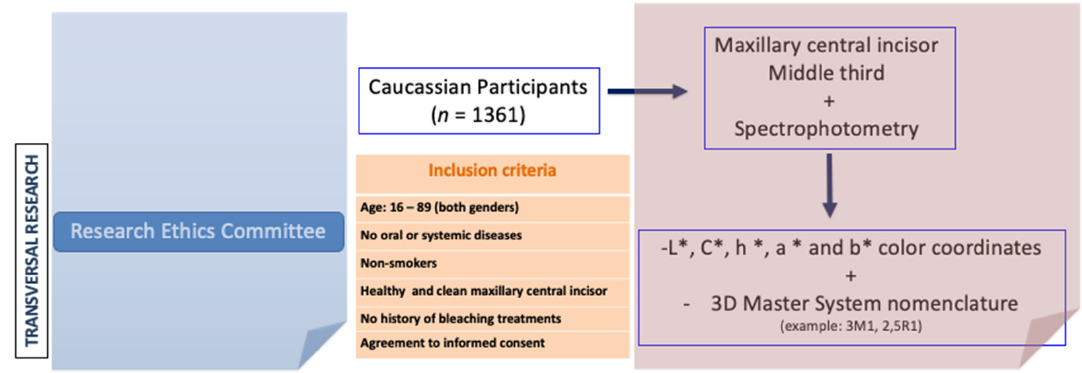
Figure 1. Graphical representation of methodology.